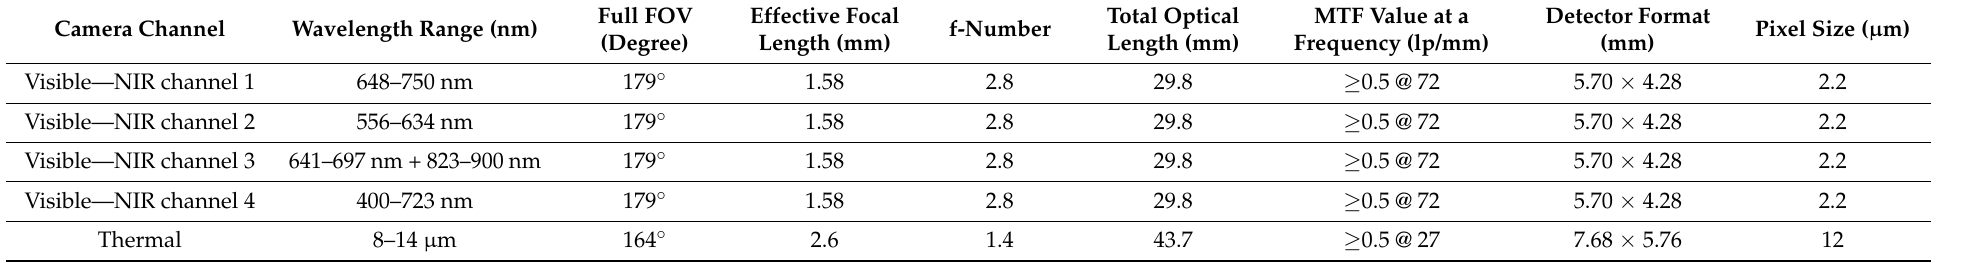
Table 4. Overview of the design specifications of our proposed five-channel camera